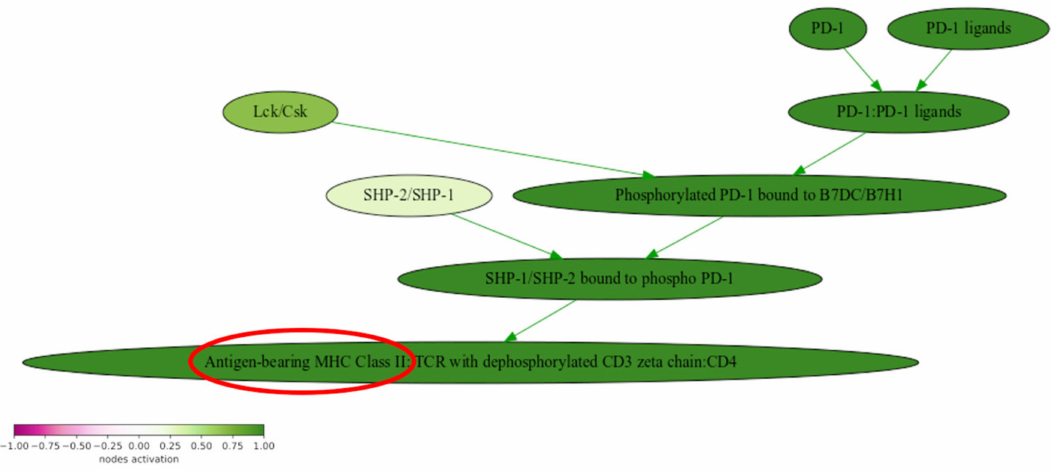
Figure 3. Pathway activation profile of the “Reactome PD-1 signaling Main Pathway” in a stomach tumor sample: mutated genes are circled in